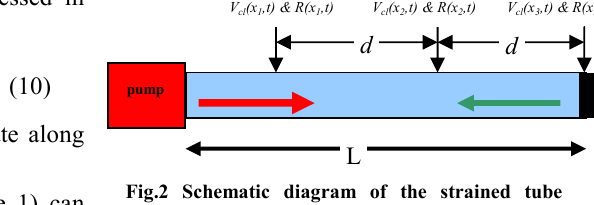
Fig.2 Schematic diagram of the strained tube closed at a distance L =44.3cm from the